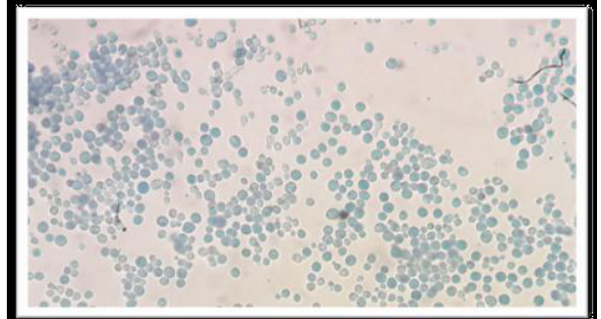
Figure 2 Candida albicans blastospores grew on SDA media and stained with cotton blue stain under light microscopy 100X magnification.